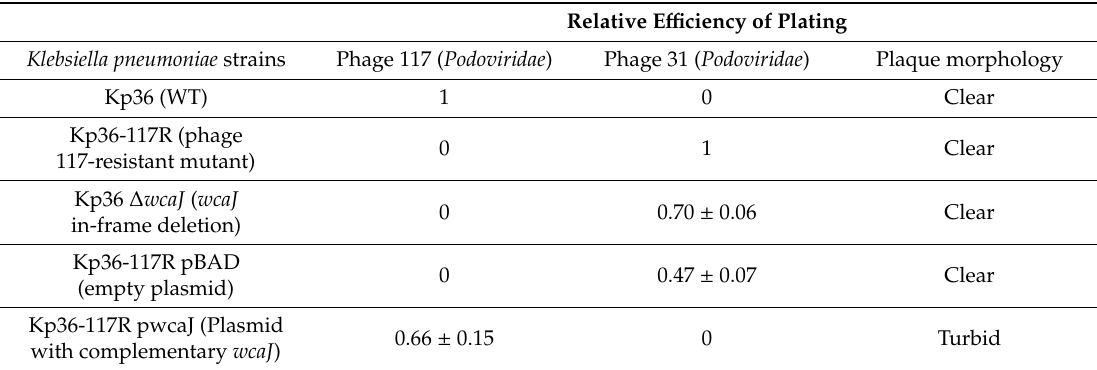
Table 1. The sensitivities of each strain to phage 117 and phage 31 were shown by calculating the e ffi ciency of plating (EOP) on K. pneumoniae strain Kp36 and its derived mutants (Kp36-117R, Kp36